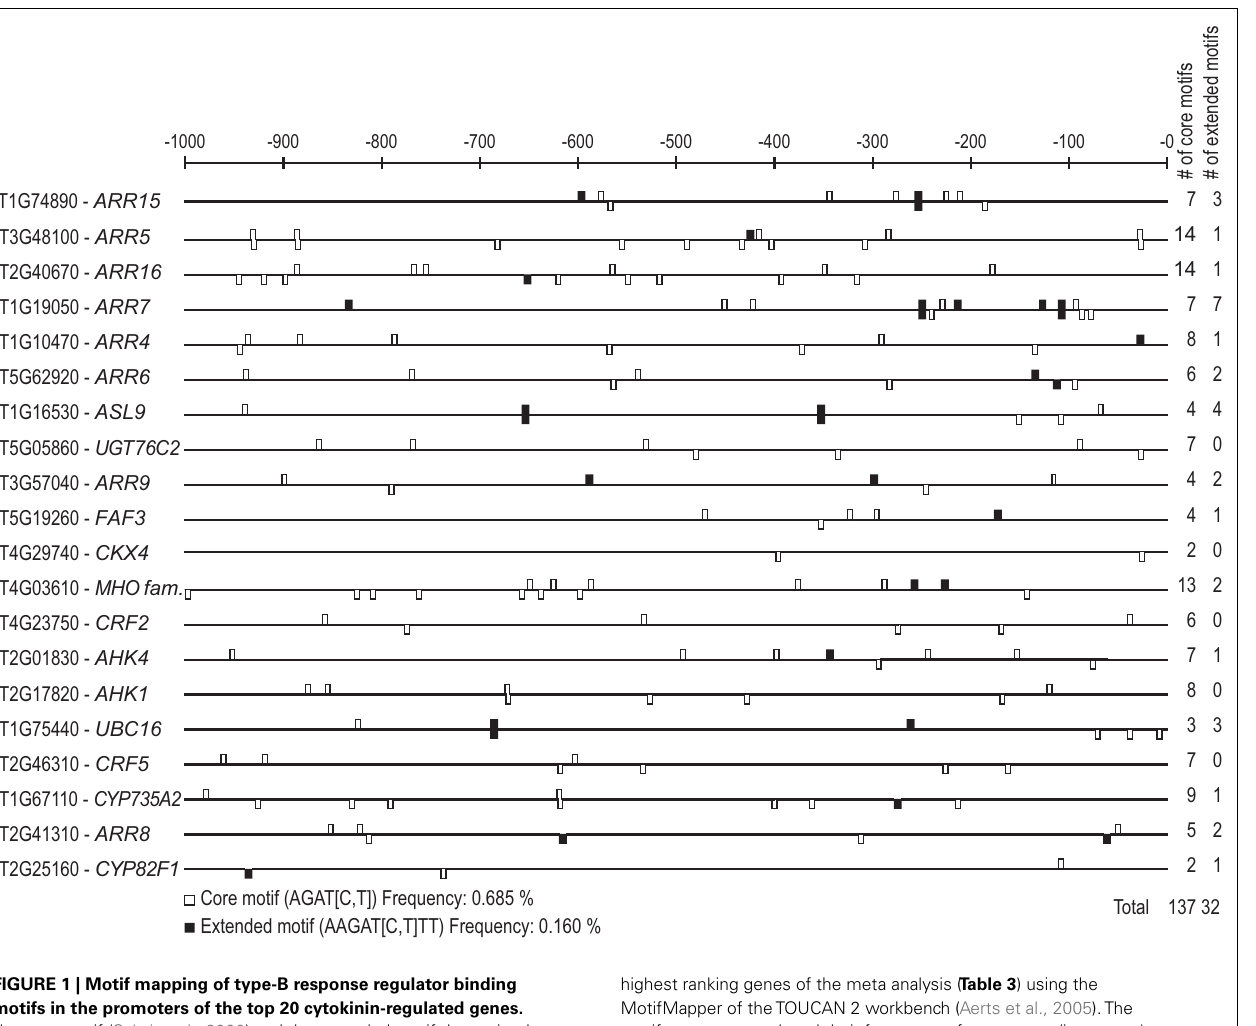
highest ranking genes of the meta analysis ( Table 3 ) using the MotifMapper of theTOUCAN 2 workbench (Aerts et al., 2005).The motifs were counted, and their frequency of occurrence (in percent) calculated using the formula (number of motifs * 100)/(20 promoters *